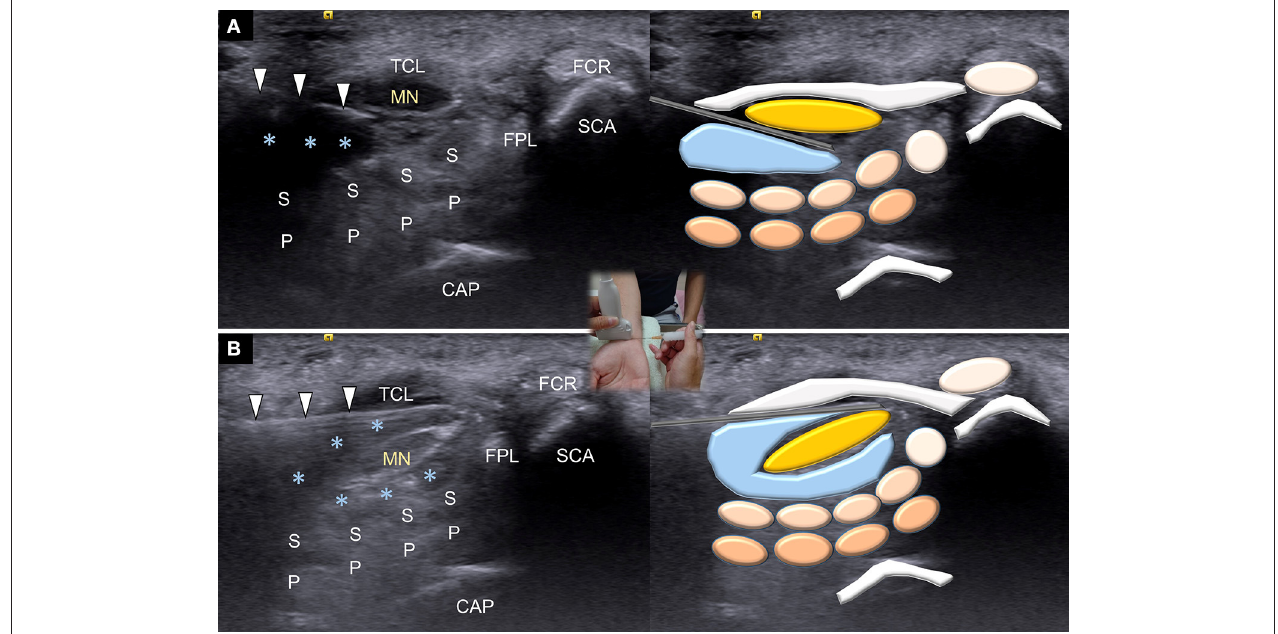
FIGURE 1 | Ultrasound guided hydrodissection for the surface under (A) and above (B) the median nerve. MN, median nerve; asterisks, injectate; TCR, transverse carpal ligament; FCR, flexor carpi radialis tendon; FPL, flexor pollicis longus tendon; S, flexor digitorum superficialis tendon; P, flexor digitorum profundus tendon; SCA, scaphoid bone; CAP, captitate bone.